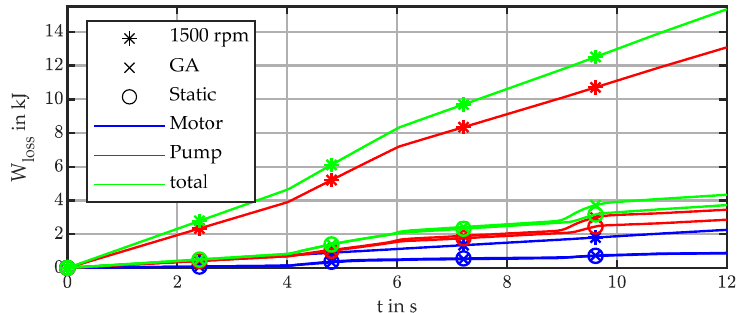
Figure 7. Energy losses for SVVDP with both optimization strategies and VDP at 1500 rpm.